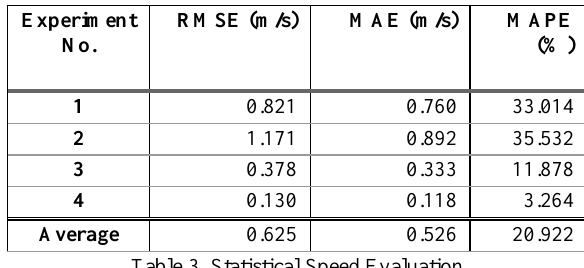
Table 2. Mean Speed Evaluation